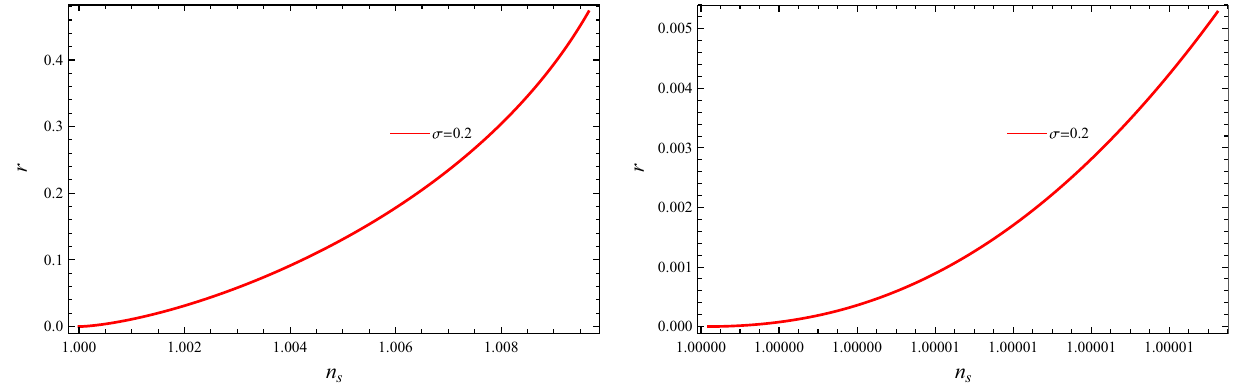
Fig. 9 Plot of r versus n s for MCG model in weak (left panel) and strong (right panel) dissipative regimes for positive potential with n = − 2